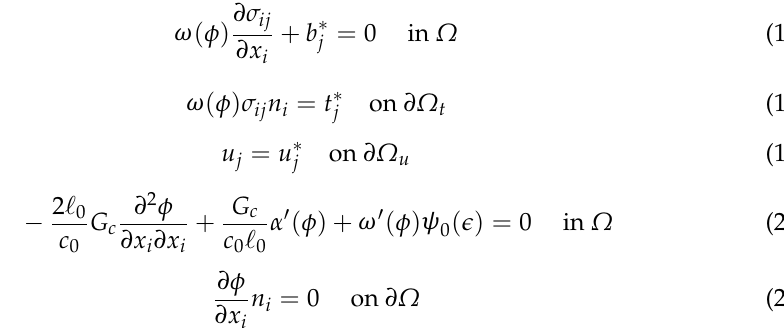
and ∂𝛺 (cid:3048) , with ∂𝛺 (cid:3047) ∩ ∂𝛺 (cid:3048) = ∅ and ∂𝛺 (cid:3047) ∪ ∂𝛺 (cid:3048) = ∂𝛺 , in which it is given displacements 𝒖 ∗ for